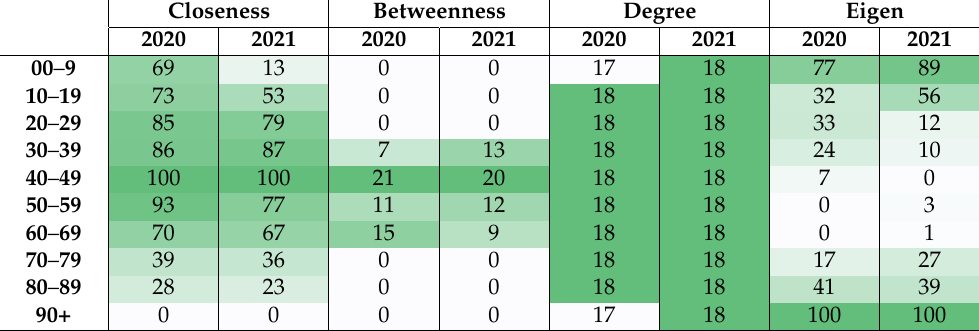
Table 5. Centrality measures of the digraph related to the age groups data for 2020–2021. Closeness Betweenness